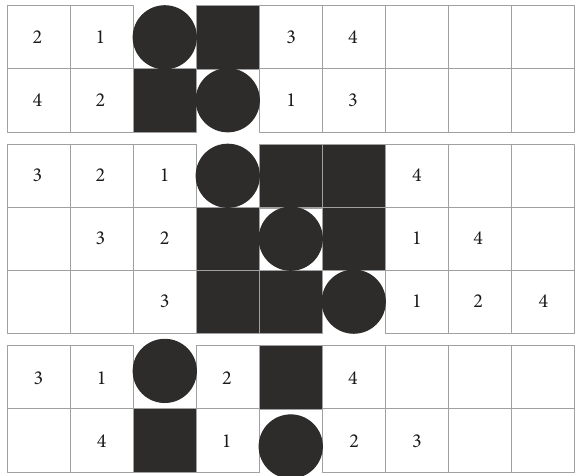
Figure 4: Inpainting schematic diagram.